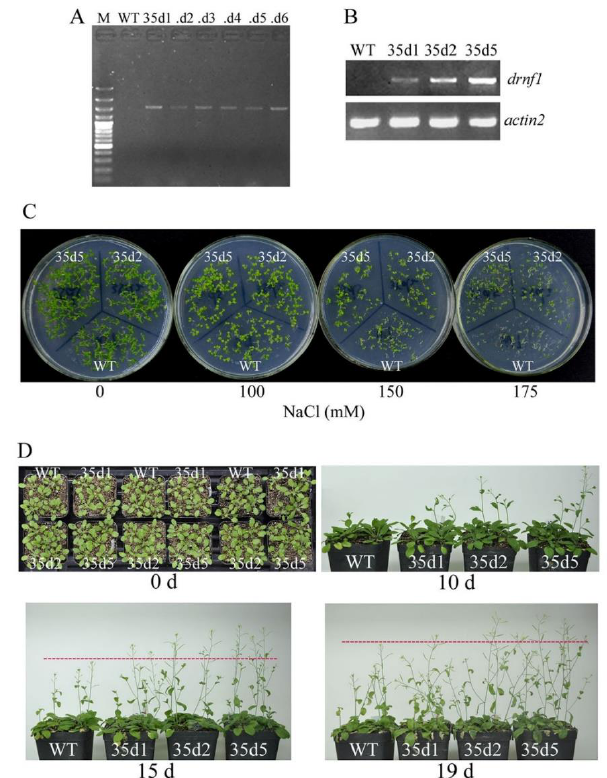
Figure 7. Identification of transgenic Arabidopsis plants and their salt tolerance phenotypes. ( A ) Identification of transgenic Arabidopsis plants and their salt tolerance